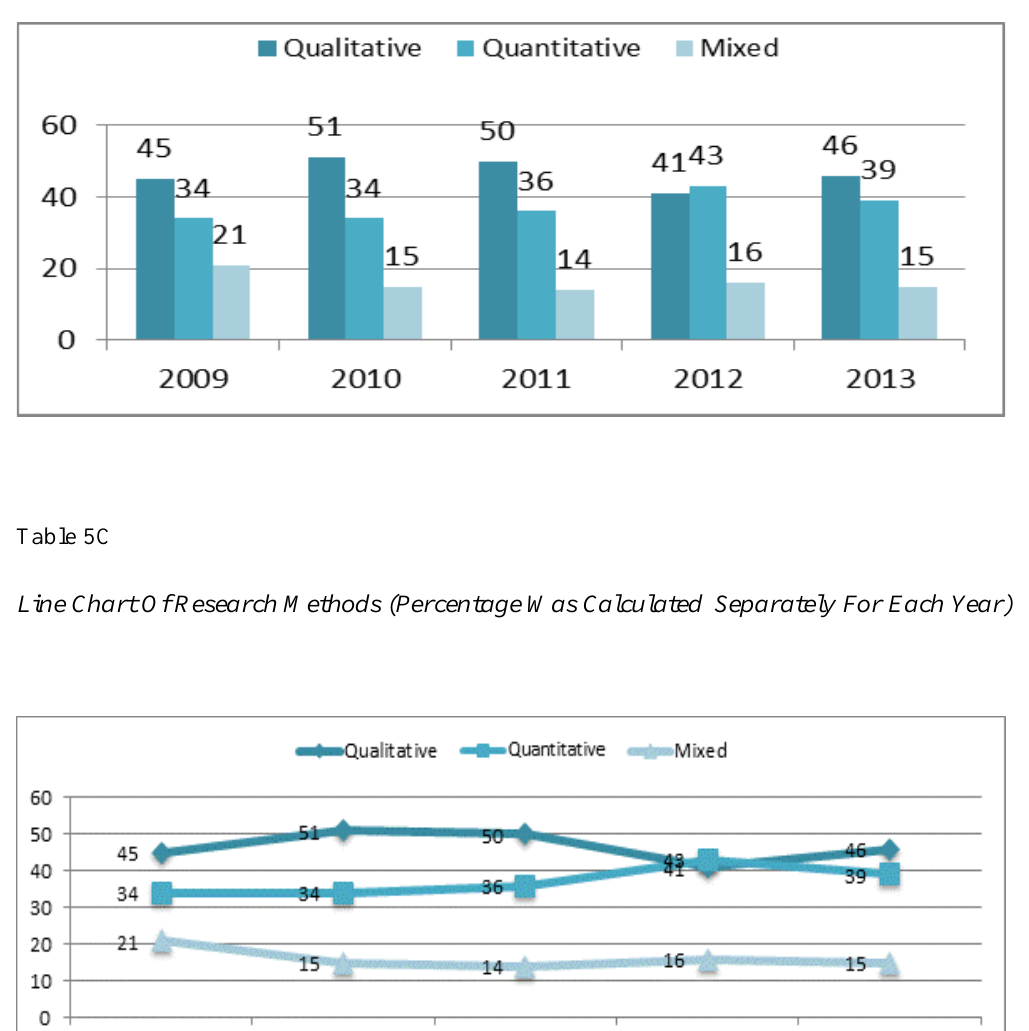
Bar Chart Of Research Methods (Percentage Was Calculated Separately For Each Year)